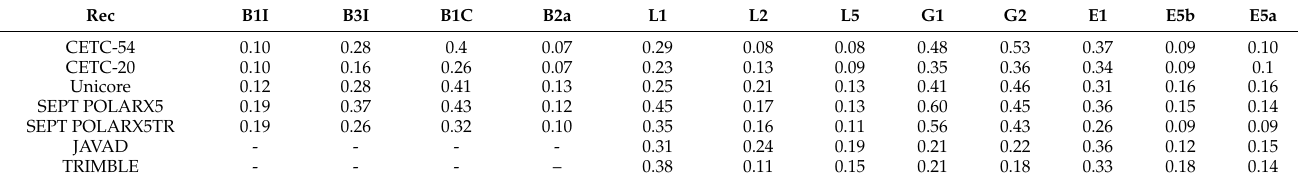
Table 7 summarized the multipath error of receivers. For BDS, only the multipath error of BDS-3 satellites is calculated because they can receive both B1I/B3I and B1C/B2a signals. The multipath errors of B1I, B3I, and B2a are within 0.3 m but the multipath error of B1C is around 0.4 m, which might be caused by the lower signal power level of the B1C signal. The ability of depressing multipath grows in turns for B1C, B3I, B1I, and B2a. For GPS and Galileo, the multipath error of L1 is larger than L2 and L5, and the multipath error of E1 is larger than E5a and E5b. For these signals with overlapping frequencies, the figure also indicates that the differences of the multipath for L1/E1/B1C and L5/E5a/B2a signals are small. Their multipath errors are about 0.4 m and 0.1 m, respectively. Multipath errors of E5a (1176.45 MHz) and E5b (1207.14 MHZ) are very close for all receivers and vary in the range from 0.09 m to 0.15 m. Table 7. Mean pseudorange multipath of receivers from 4 manufacturers (unit: